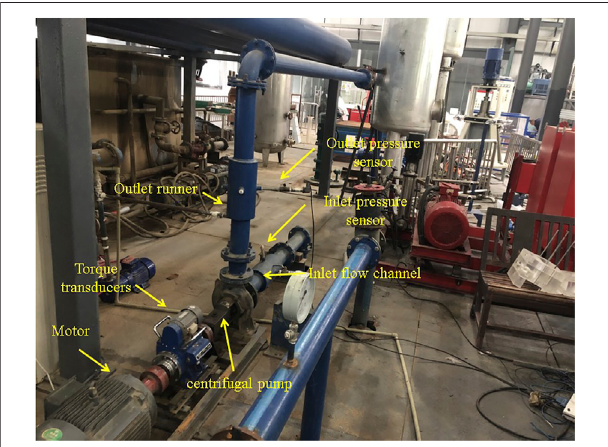
FIGURE 5 | Field experimentation.